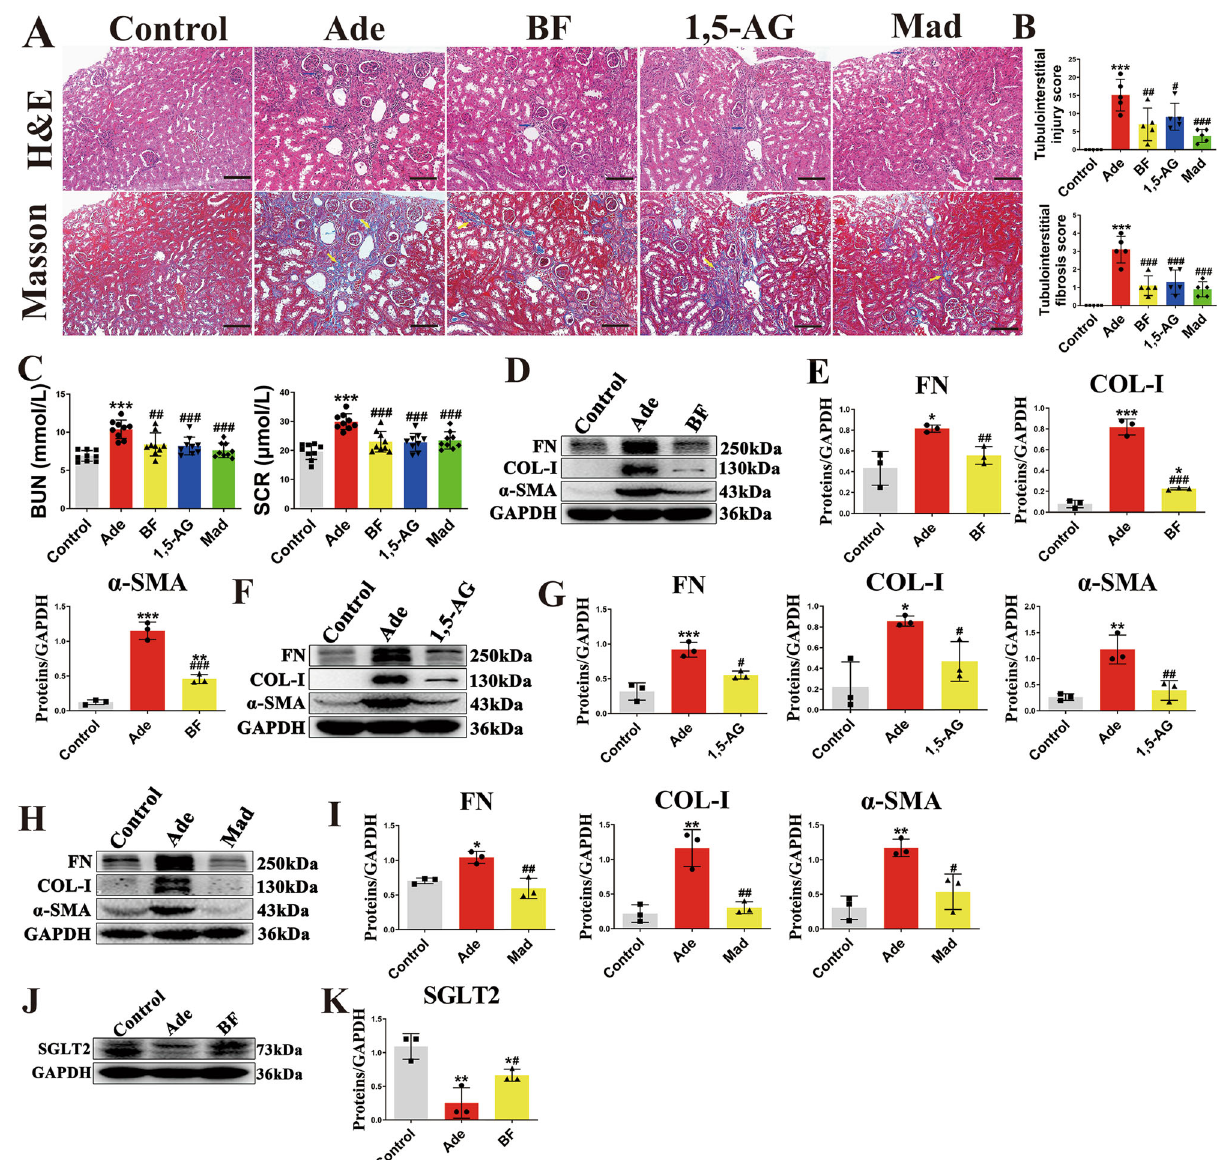
Fig. 7 | The anti- fi brotic effects of B fragilis , 1,5-AG and Mad in the adenine model. A Representative photomicrographs of the H&E staining and Masson ’ s trichromestainingfromleftkidneysofsham,adenine, B.fragilis -treatedUUOmice, 1,5-AG-treated adenine mice and Mad-treated adenine mice (H&E and Masson ’ s staining; scale bar, 100 μ m, magni fi cation, ×200). B Bar graphs depict renal injury scores and renal interstitial fi brosis scores based on H&E staining or Masson ’ s trichrome staining ( n =5). *** p <0.0001 for injury score: Control vs. Ade, ## p =0.0045forinjuryscore:Adevs.BF, # p =0.0421forinjuryscore:Adevs.1,5-AG,